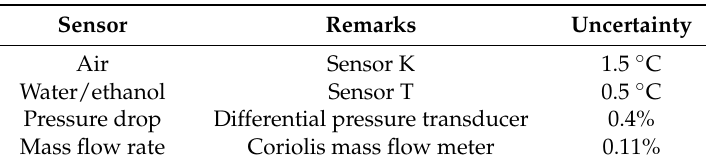
Table 2. Description of the main sensors of the test